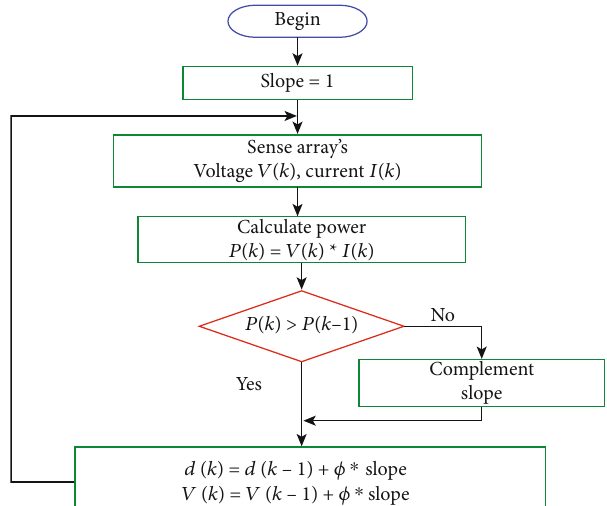
Figure 4: Perturb and observe algorithm for MPP tracking.